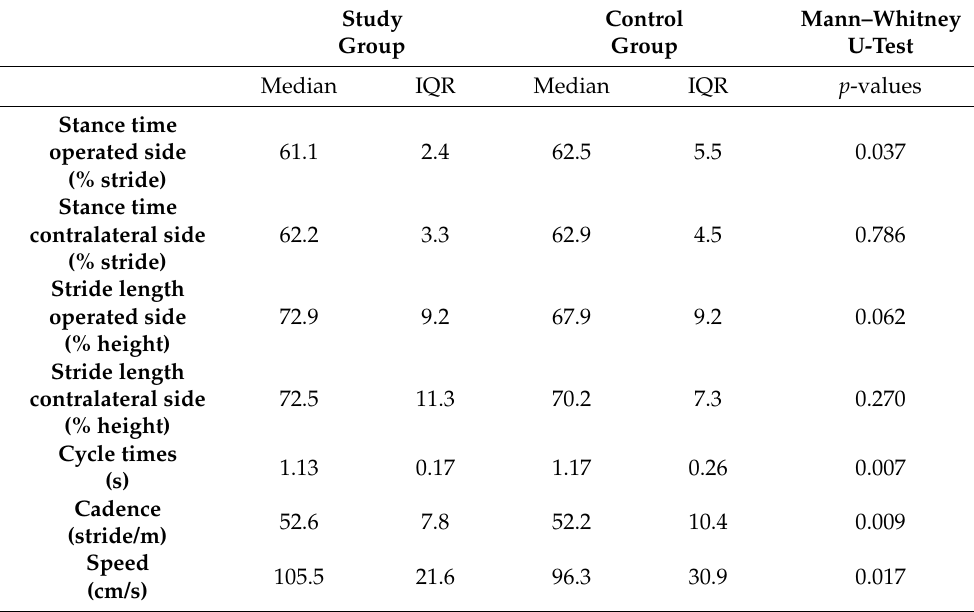
Table 2. Comparison of time–distance